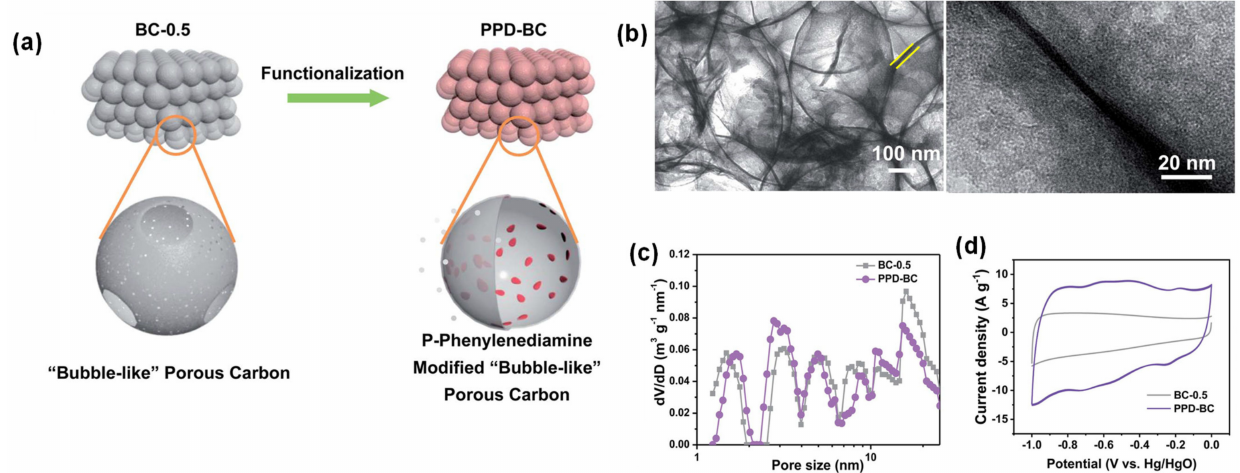
Figure 10. ( a – d ) fabrication process, morphology, pore size distribution, and CV profile of BC-p-PD composite electrode. Reproduced with permission from Ref.